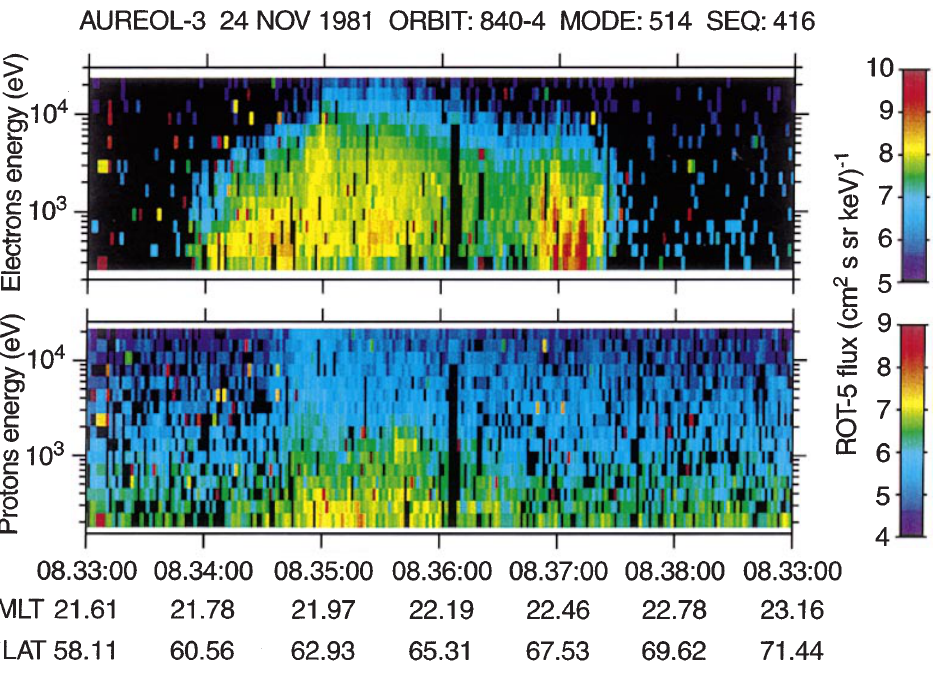
Fig. 2. AUREOL-3 electron and ion (proton) di(cid:128)erential flux spectrograms from (cid:24) 200 eV to (cid:24) 22 keV, during the southern pass 840S over Antarctica on Nov. 24, 1981 around 0835 UT (altitude: (cid:24) 1300 km), measured by the SPECTRO/ROT_5 sensor (pitch angle: (cid:24) 30 (cid:176) ). Di(cid:128)erential fluxes are expressed in (cm 2 s sr keV) )